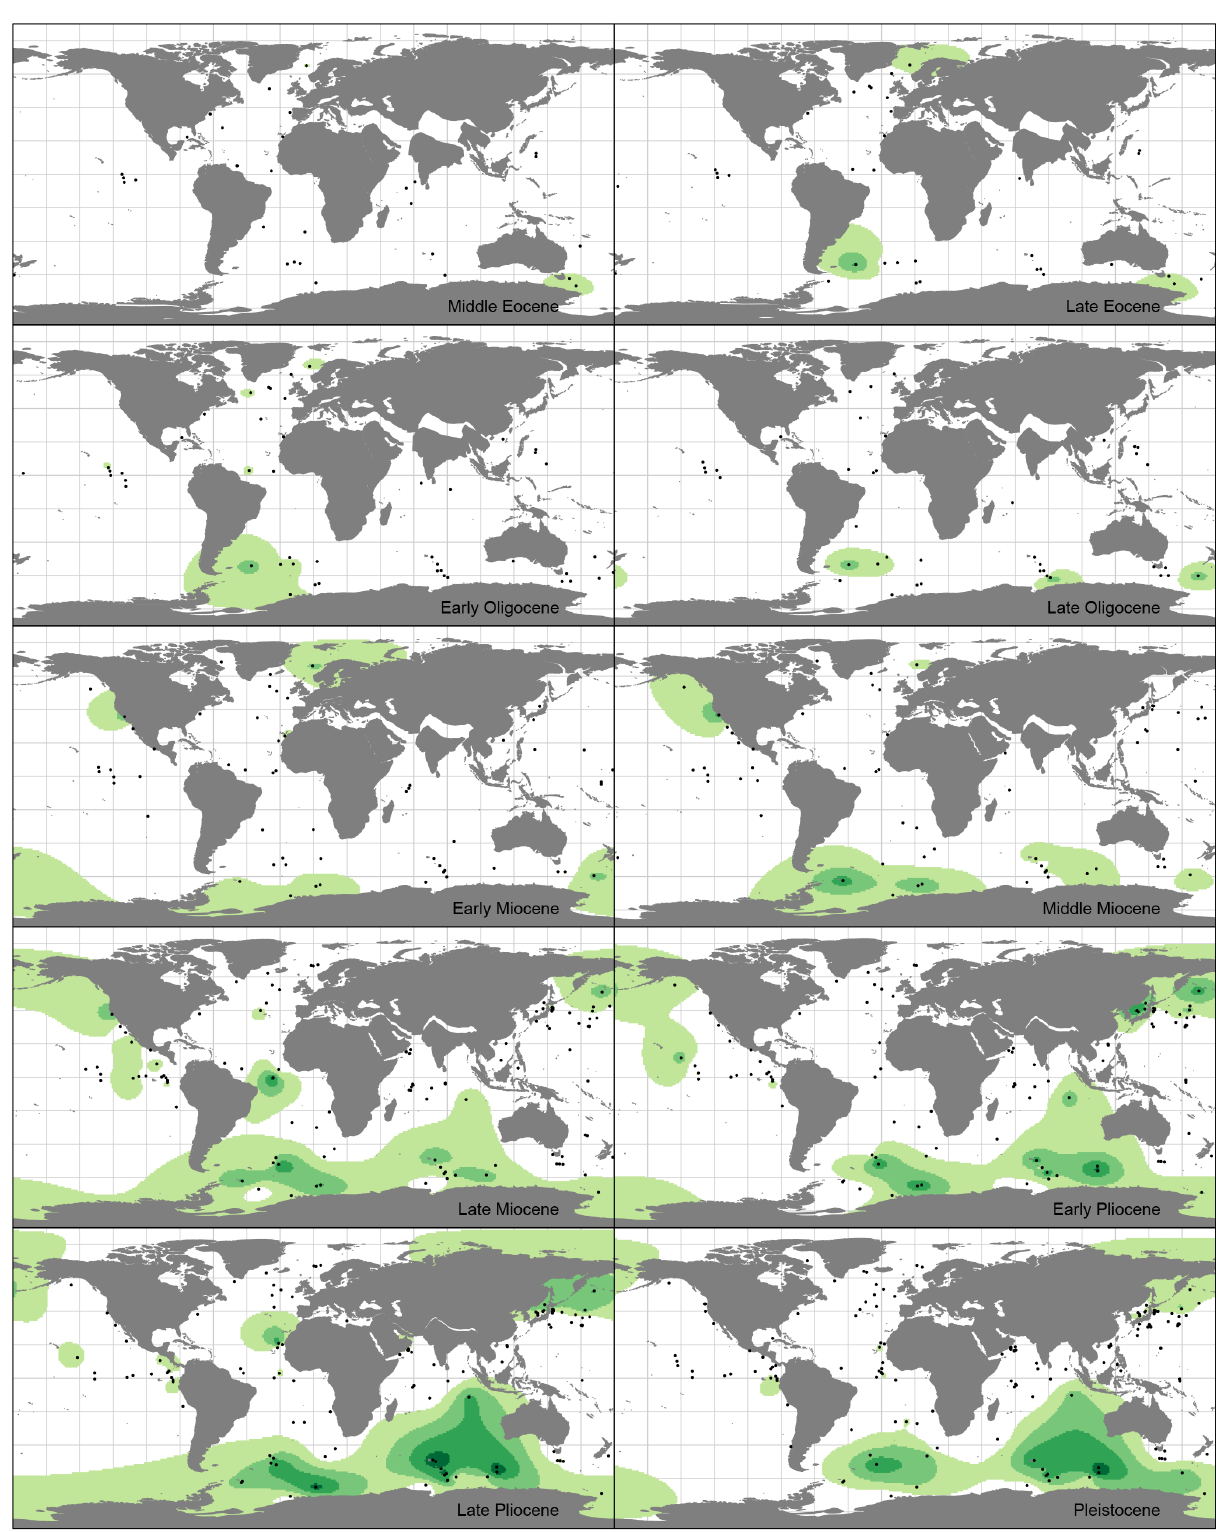
Figure 4. Maps of diatom abundance in DSDP-ODP smear slides during the Cenozoic. Black dots are the diatom-bearing sites present in the concerned sub-epoch. From white to dark green, the categories correspond to less than 20%, 20 to 40%, 40 to 60%, 60 to 80%, and more than 80% (see Fig. 2 for the color scale). Diatom abundance is interpolated using ordinary kriging based on an exponential model. Paleogeography from Müller et al.